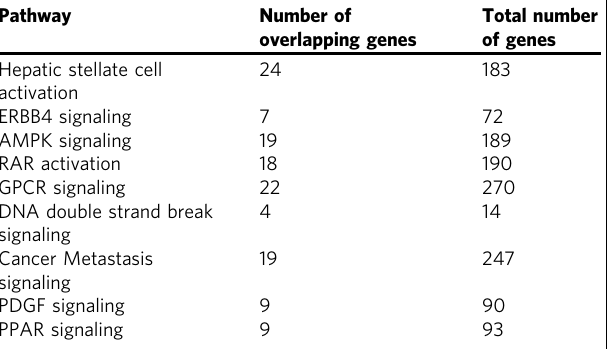
Table 1 Key molecular pathways and the total number of overlapping genes in each pathway in metastatic ACC tumors Pathway